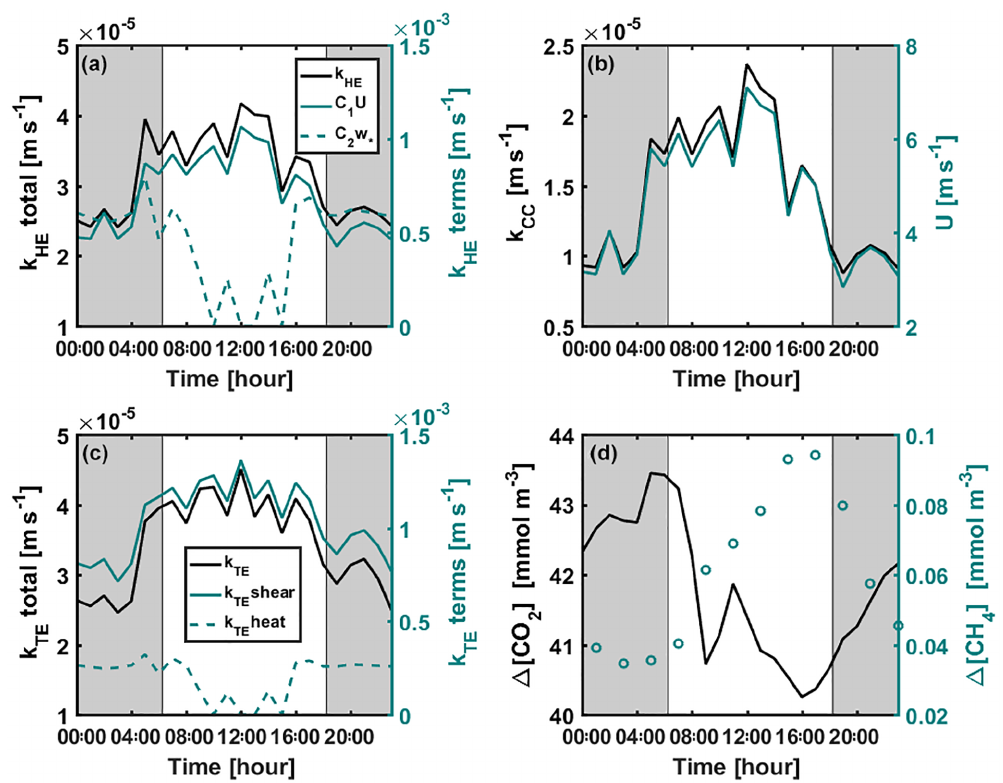
Figure A2. Diurnal variation of (a) k HE and its shear and convective terms (Eq. 9), (b) k CC and wind speed, (c) k TE and its shear ( k TE shear = 3 c 1 u 3 ∗ w ∗ w or k TE shear = c 3 u ) and convective ( k TE heat = c 2 | β | or k TE heat = 0) terms (Eq. 8), and (d) CO 2 and CH 4 concentration differences κz κz between air and surface water during the mixing period 22–26 September 2014. Shear and convective terms in subplots (a) and (c) are not corrected with the Schmidt number. Grey areas represent